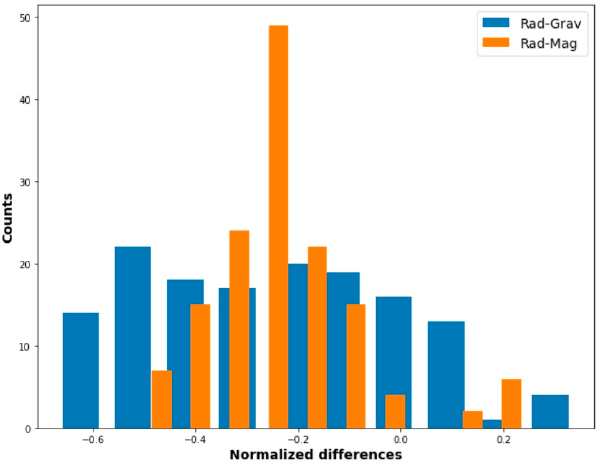
Figure 8. Bar histogram to highlight normalized differences between values of C Rn –gravity (with a tendency to a rectangular shaped distribution) and C Rn –magnetic data (showing heavier tails).